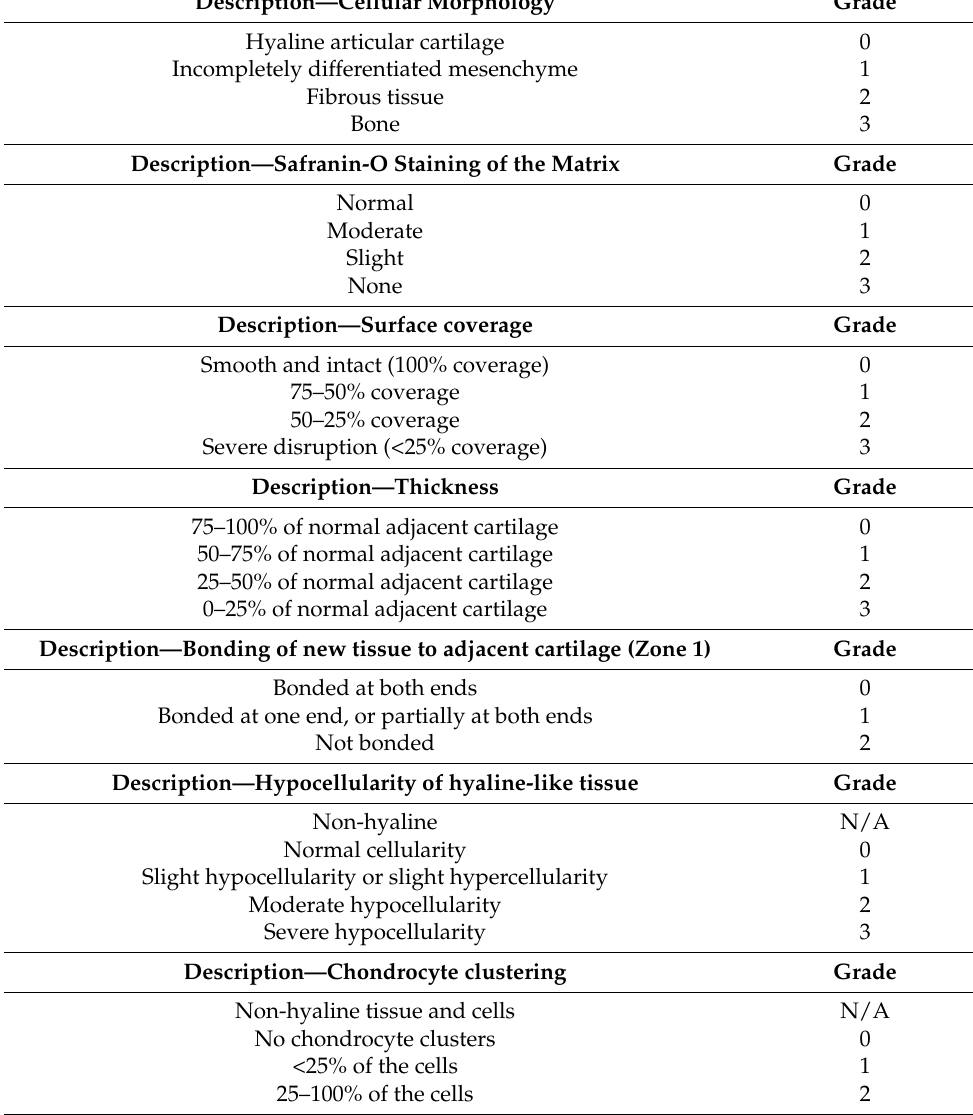
Table A2. Histological scoring scale modified from the original O’Driscoll score scale for cartilage defect repair evaluation (i.e., Zones 0 and 1). The score was used to evaluate the defect filling according to cellular morphology, Safranin-O staining, surface coverage, thickness, bonding of new tissue to adjacent cartilage, hypocellularity of hyaline-like tissue, and chondrocyte